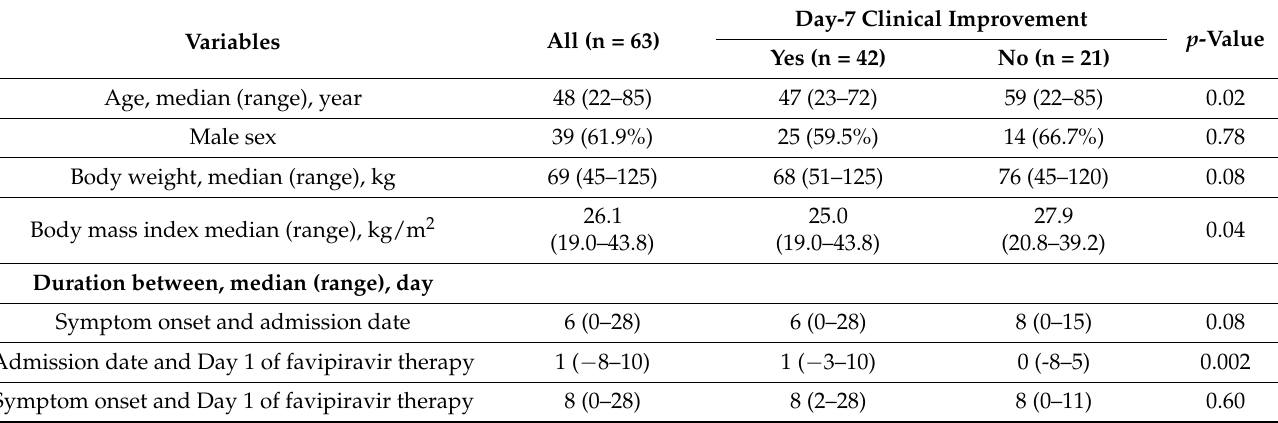
Table 1. Baseline demographics and characteristics of all